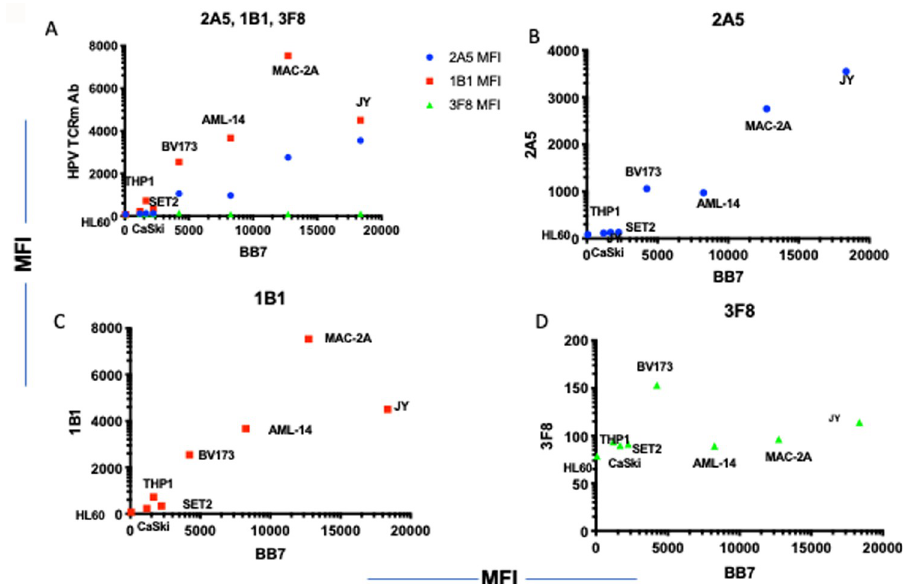
Fig 3. Correlation of HPV mAb binding and HLA-A2 expression. A panel of cell lines with variable amounts of HLA-A2 on the cell surface were stained with mAbs 1B1, 2A5 and 3F8 at 3ug/ml and BB7.2 to HLA-A2. HPV mAb binding is shown in Y-axis and HLA-A2 expression in X-Axis. [A] A comparison of all 3 mAb on the same plot. Each mAb alone is plotted: 2A5 [B], 1B1 [C], 3F8 [D]. The data is one representative from five independent